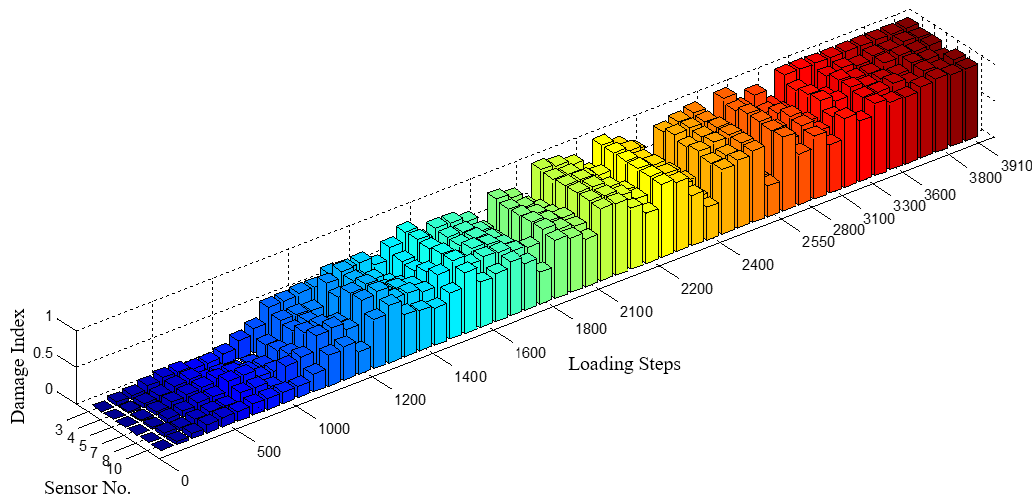
Figure 10. General damage indices throughout the test.